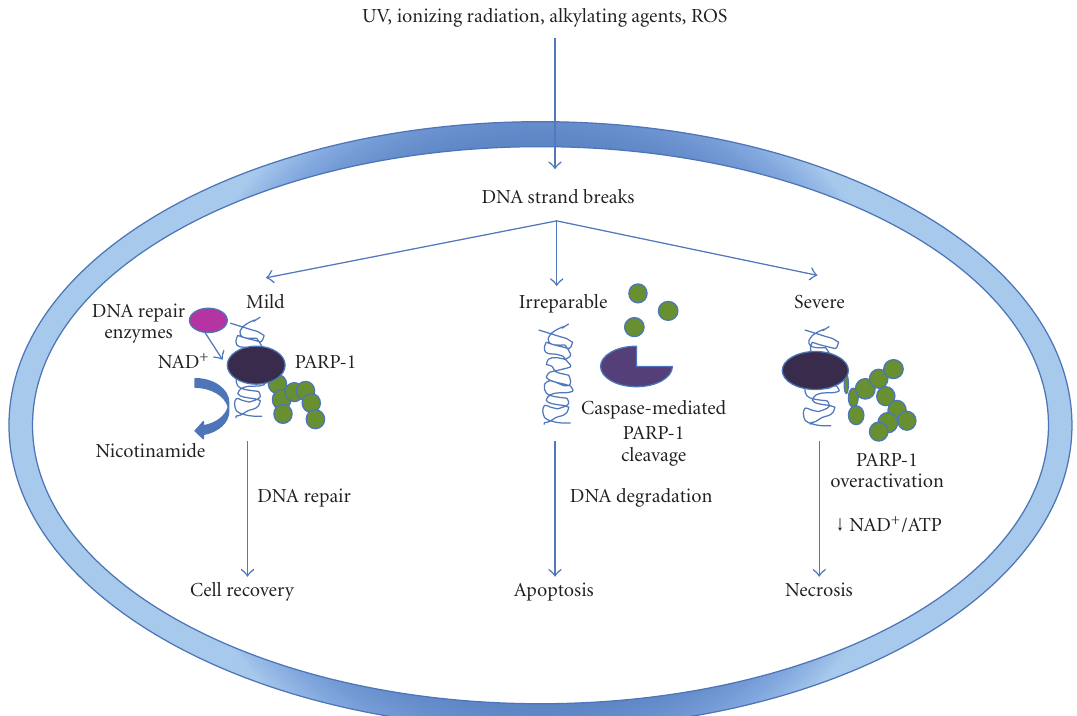
Figure 3: PARP-1 and cellular responses to DNA damage. The intensity of DNA damage determines cellular pathways: survival, apoptosis, or necrosis. In the case of mild DNA damage, poly(ADP-ribosylation) enhances DNA repair and thus cell survival. When the damage is beyond repair, PARP-1 facilitates apoptosis, preventing ATP depletion and DNA repair through PARP-1 caspase-mediated cleavage. Severe DNA damage leads to PARP-1 overactivation, cellular energy depletion, and necrotic cell death. Figure is adapted from Vir´ag and Szab´o, in 2002